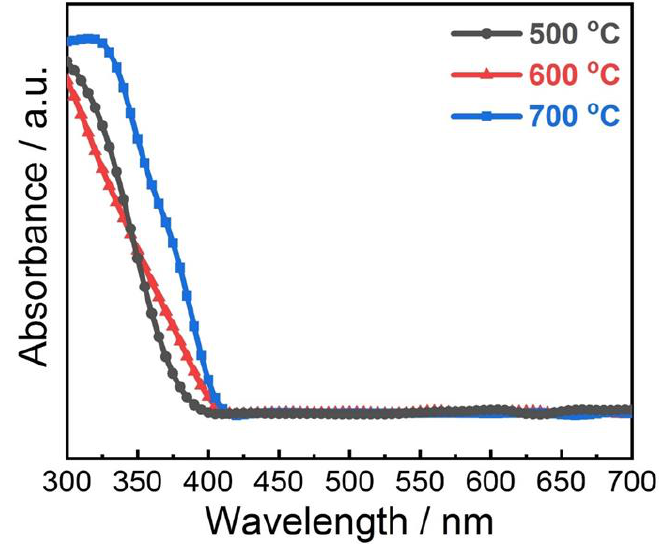
Figure 5. Normalized absorbance spectra of TiO 2 nanotubes annealed at different temperatures.